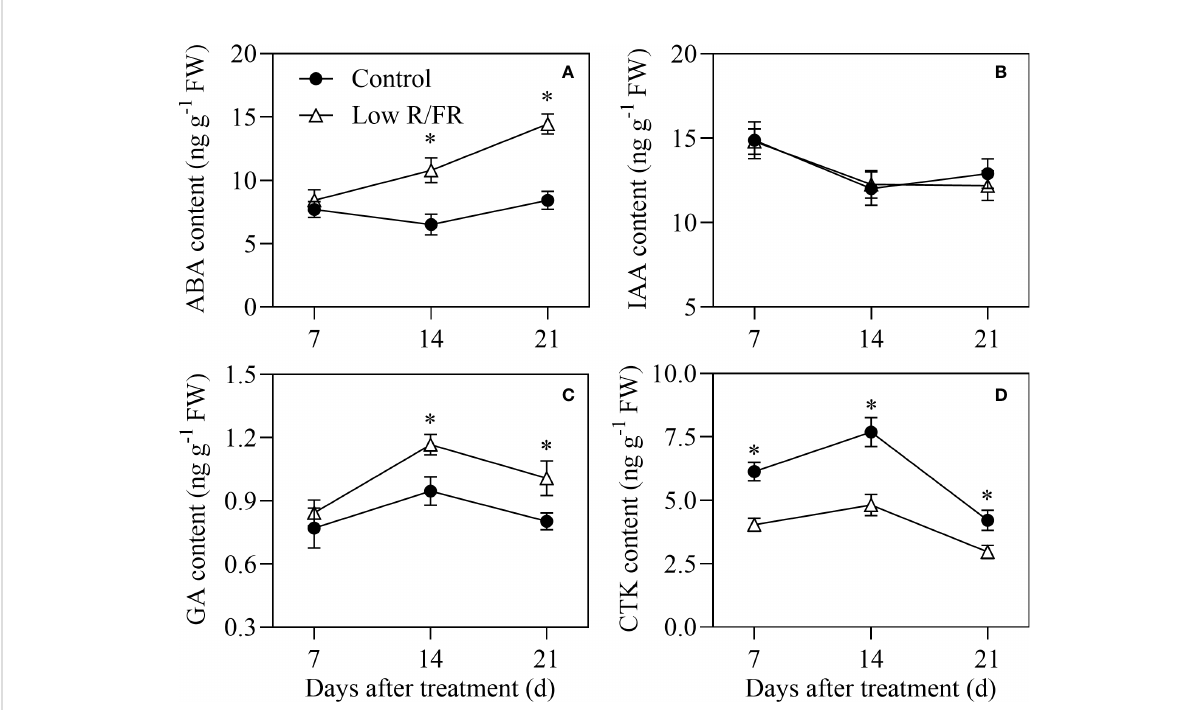
FIGURE 2 Abscisic acid (ABA) abundance in the tiller IV and auxin, gibberellin (GA) and cytokinin (CTK) levels in tiller nodes and under control and low R/FR conditions. ABA (A) levels in the tiller IV and indole-3-acetic acid (IAA;) (B) , GA (C) and CTK (D) levels in tiller nodes treated for 7, 14 and 21 d. GA levels were the sum of GA 1 and GA 4 . CTK levels were the sum of t Z and t ZR. Data are the means of three biological replicates ± SE, and the asterisk denotes a statistically remarkable difference ( P < 0.05) between treated and control